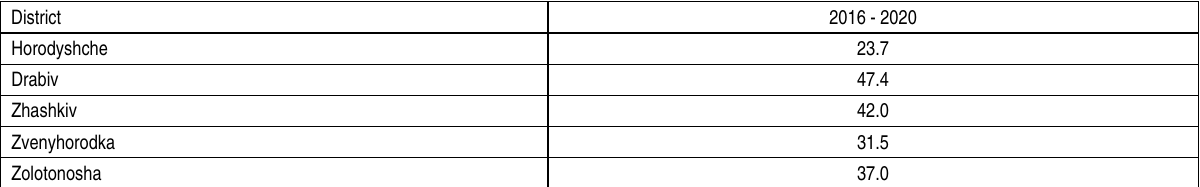
Table 5. Recommended amounts of green manure crop in Cherkasy region, the hectares